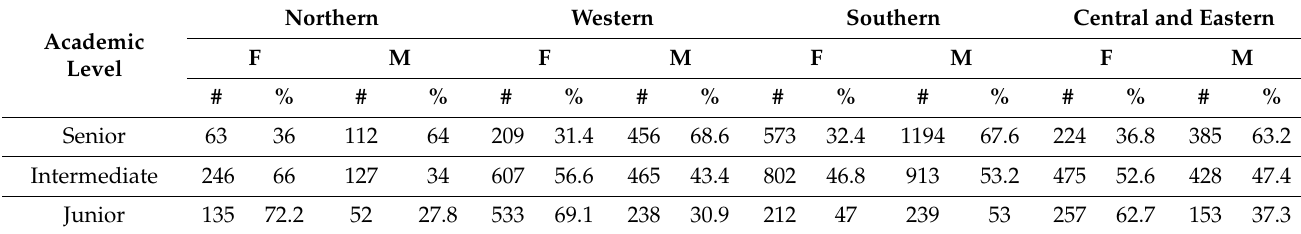
Figure 5. Scissor diagram showing the gender distribution within different academic levels in European veterinary schools. Table 7. Gender distribution across different academic levels in European subregions .